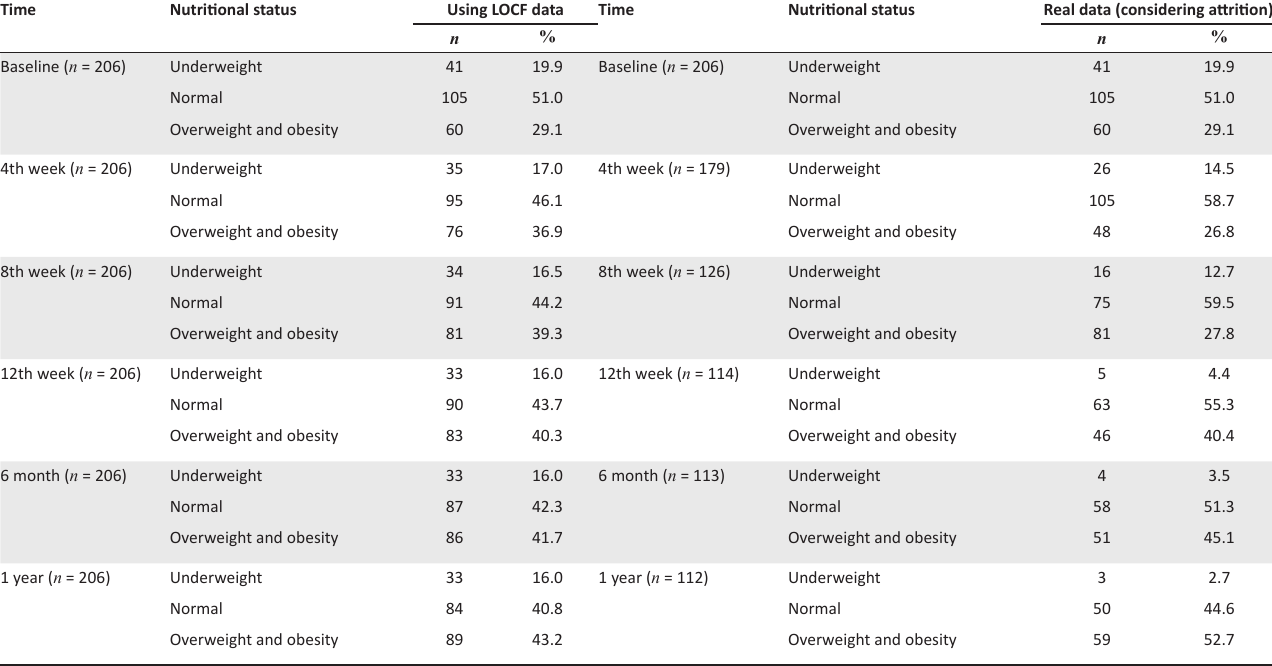
TABLE 2: Nutritional status across the intervals of treatment follow-up using last observation carried forward and real attrition data. Time Nutritional status